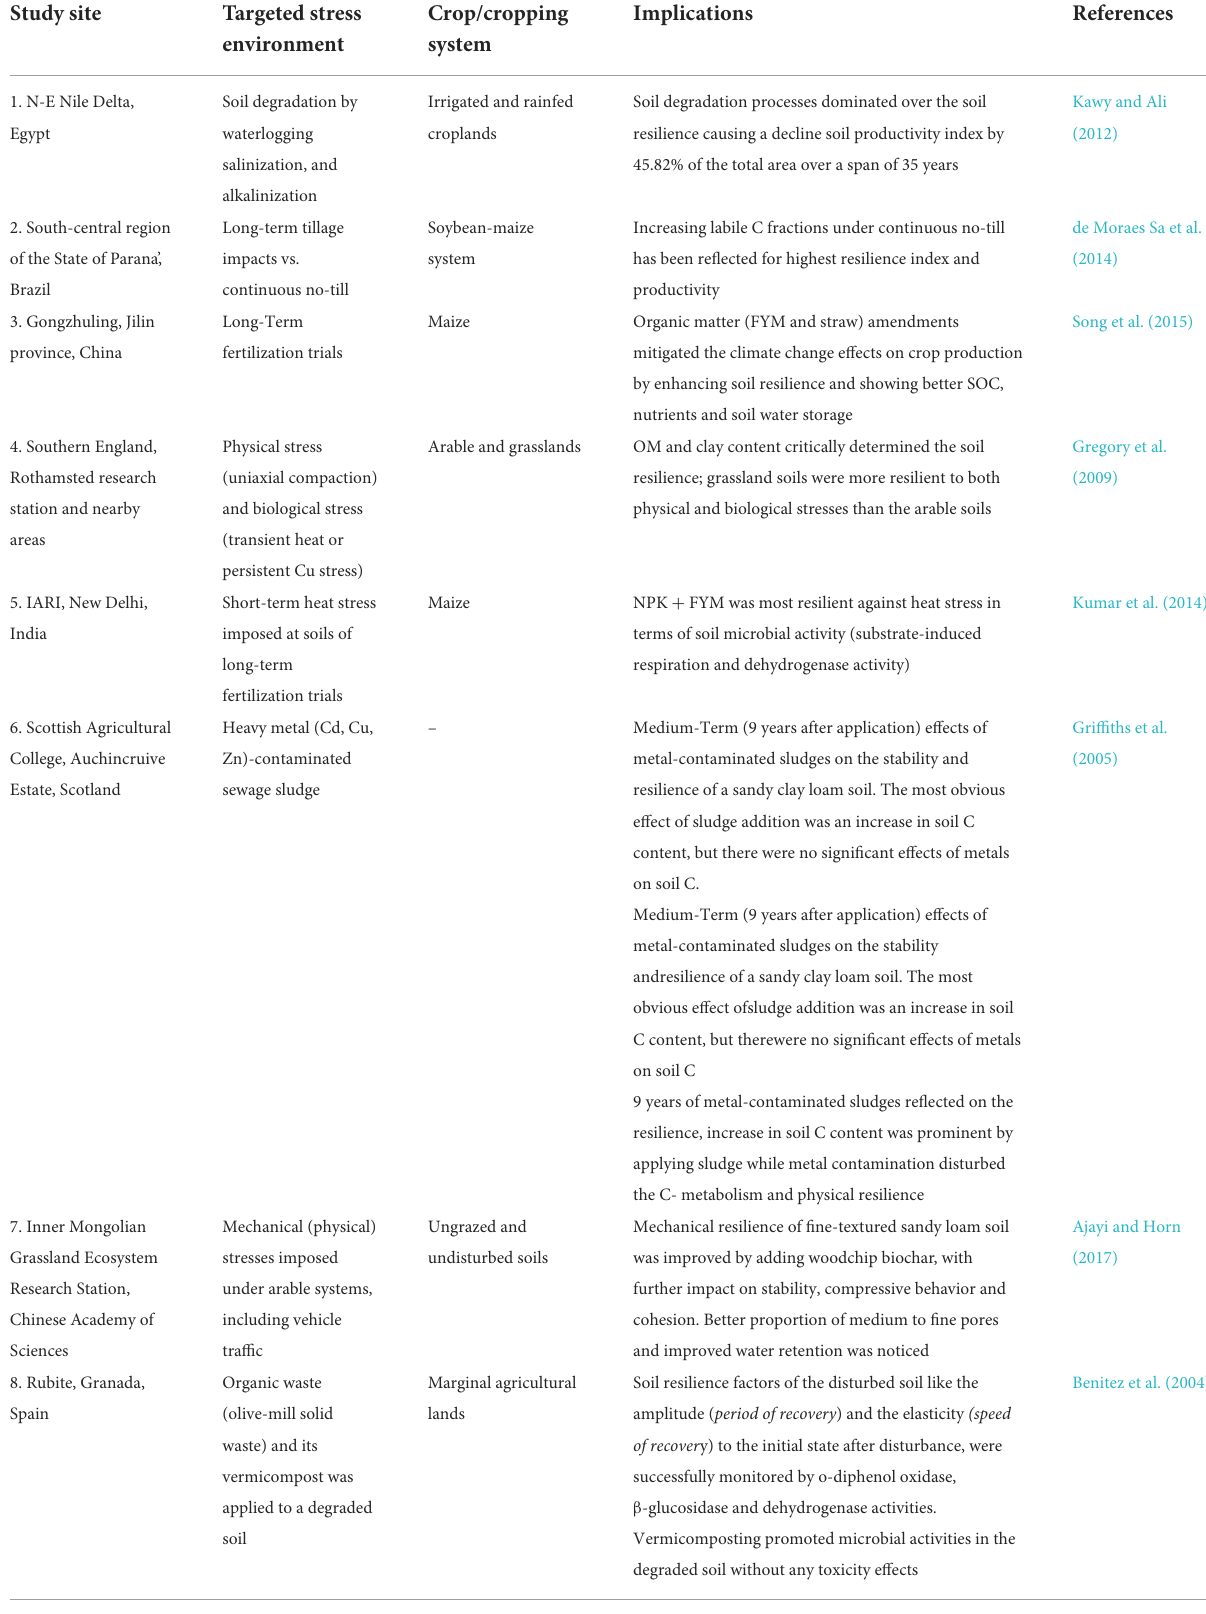
TABLE 2 Soil resilience model for improving agricultural productivity and environmental